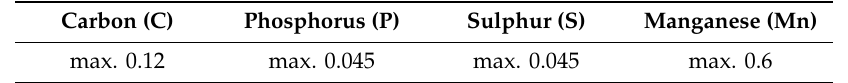
Table 1. Chemical composition of the DC01 steel according to manufacturer data in percent by weight.